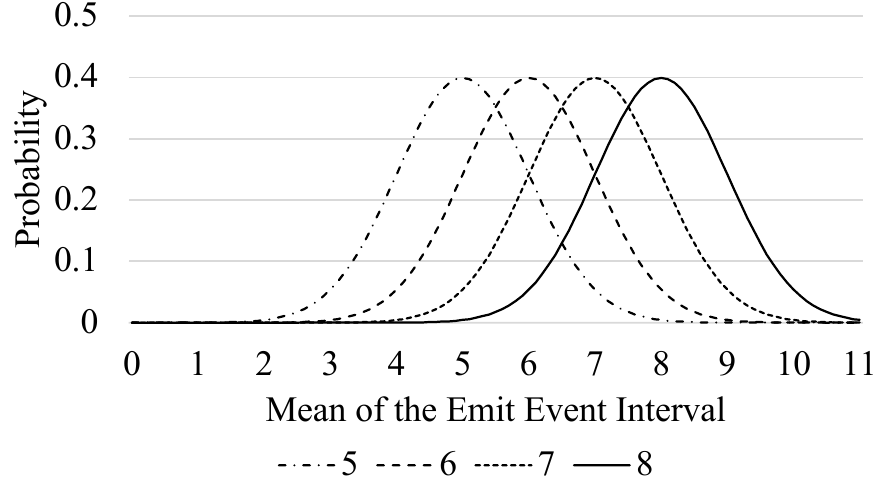
Figure 2. Probability of the emit interval in different